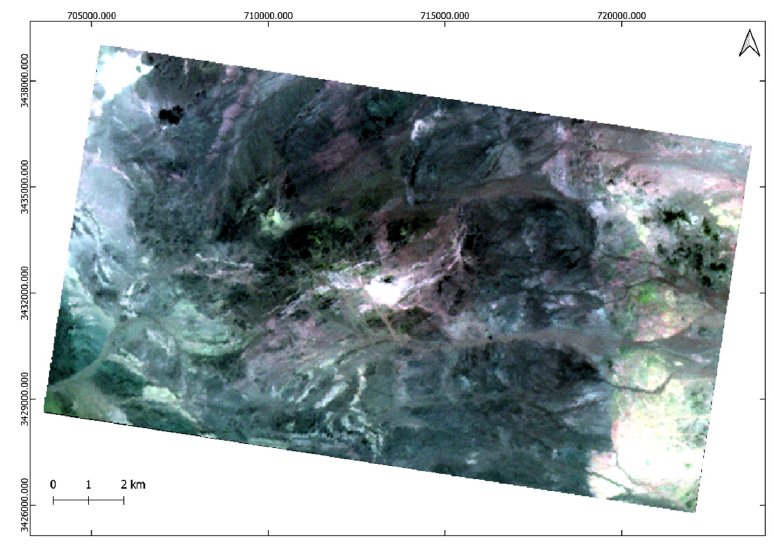
Figure 3. RGB color combination of bands 4, 6 and 8 to detect propylitic and phyllic alterations. Propylitic alteration zone appears in green color, while phyllic alteration is depicted in pink to yellow. 4.2. Band Ratio (BR).